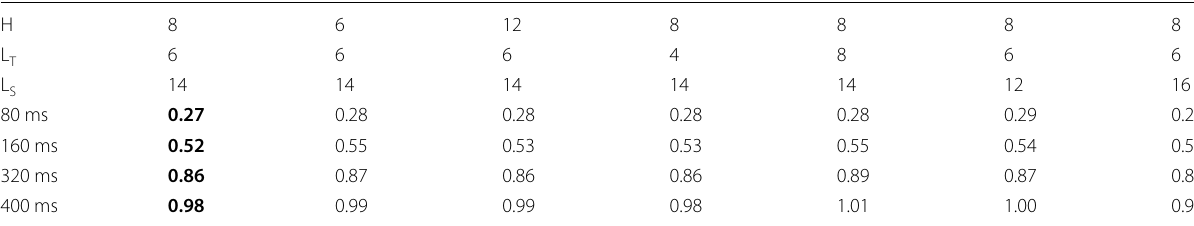
Table 3 The ablation experiments for different module parameters in STTG-Net, with reported results for joint angle errors on Human3.6M